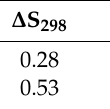
Figure 10. Comparison of deconvoluted thermograms of dsDNA (blue) and dsDNA*-PEP (red). Table 2. Calculated thermodynamic